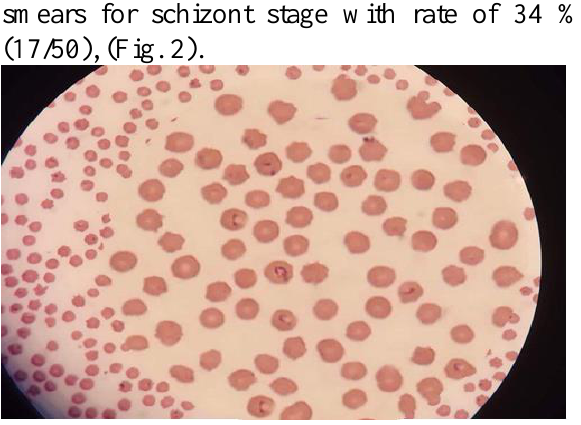
Figure, 1: Erythrocytic stage, Piroplasm of Theileria spp. In cattle blood smear (x 100).